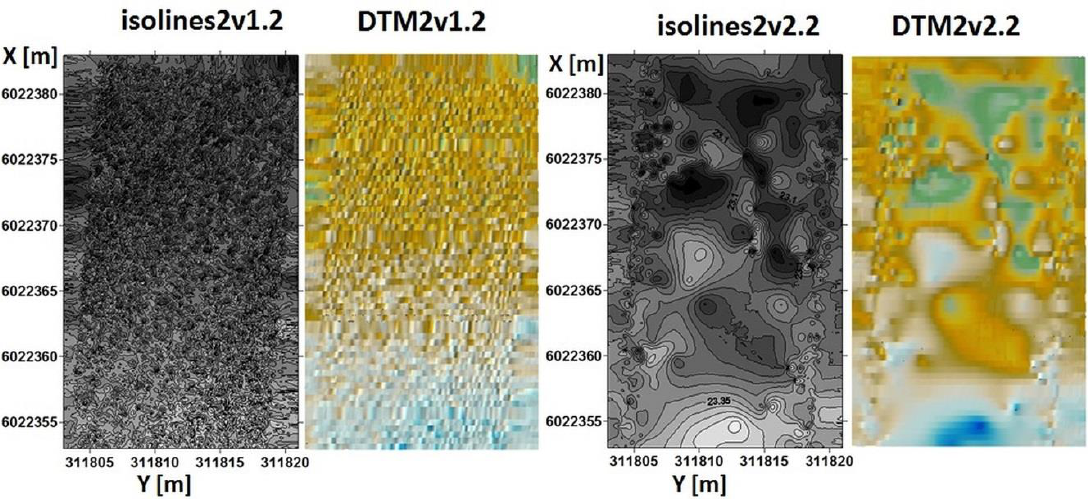
Figure 13. Isolines2v1.2 and DTM2v1.2, and isolines2v2.2 and DTM2v2.2 generated for strip 2 (po 2 ) by methodologies v1.2 and v2.2, respectively.